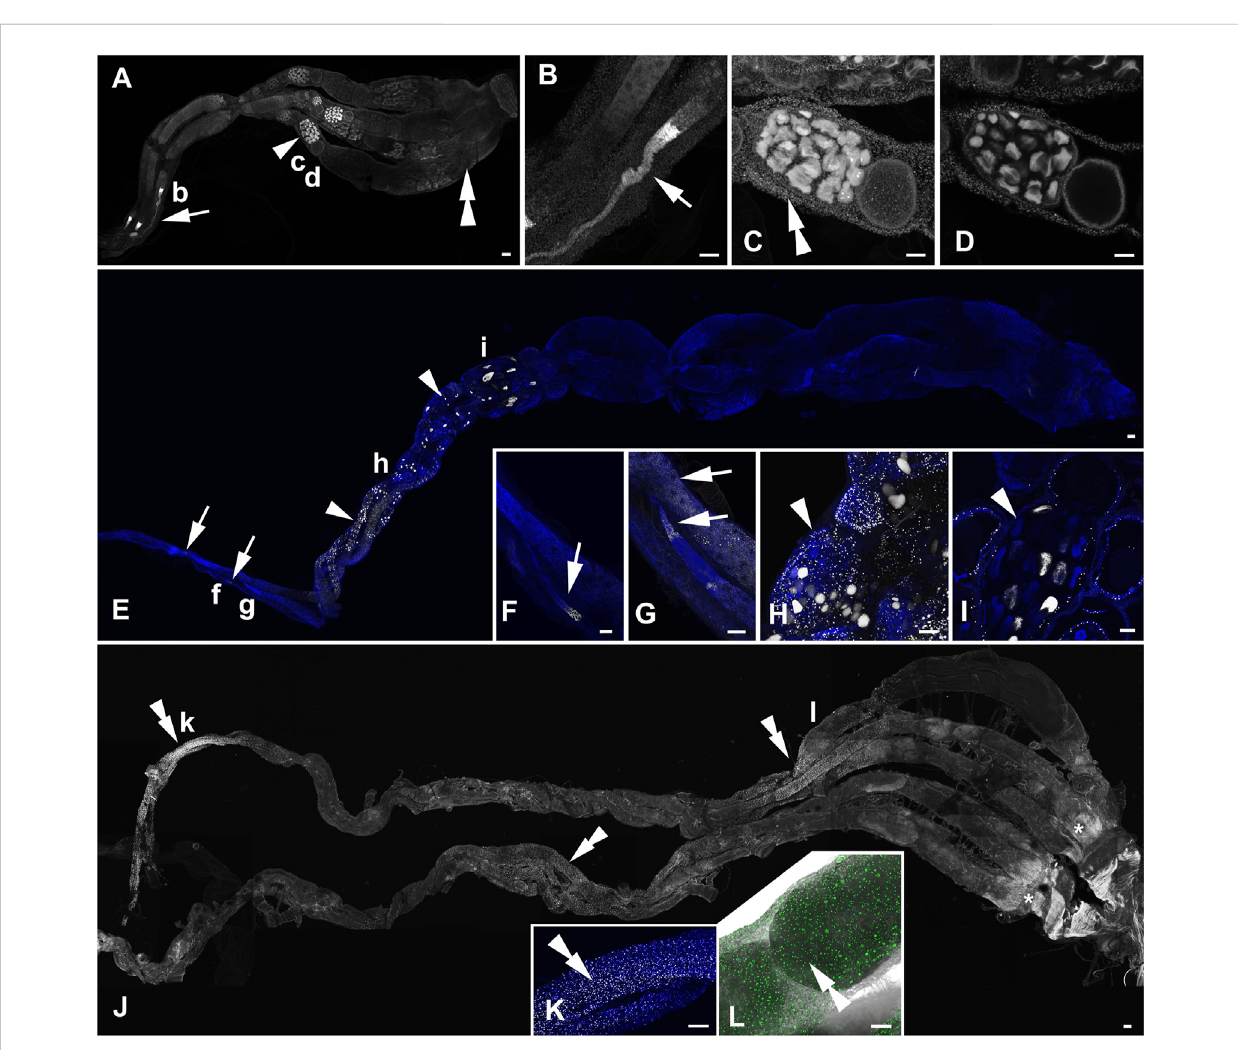
Active DNA synthesis in the ovaries of B. terrestris queens within a 12 h period. (A – D) The ovary of a representative of 3 to 8-day-old virgin queens. The3Dreconstructionofthewholeovary (A) ,strongEdU-labellingintheterminal fi lamentandtheanteriorpartofgermarium (B) ,theclose-upviewofan oocyte chamber with EdU-positive signals in nurse cells (trophocytes), follicle cells, and in the peritoneal sheath of the vitellarium in the Z stack reconstruction (C) ,andinasingleconfocallayer (D) . (E – I) Theovaryofarepresentativeof15-to20-day-oldmatedprediapausequeens.Mitotically active cells in the germarium and the vitellarium in the 3D reconstruction of the whole ovary (E) , details of the EdU-signal in the anterior part of the germarium (F,G) , the close-up view of EdU signals in follicle cells and some trophocytes in an egg chamber of the middle part of the vitellarium in the Z stack reconstruction (H) and in a single confocal layer (I) . (J – L) The ovary of a representative of 1-year-old queens. EdU labelling of some cells of the peritoneal sheath in the 3D reconstruction (J) , details of the proximal part of ovarioles (K) and the middle part of an ovariole (L, the fl uorescence signal is combinedwiththetransmittedlightimage).Thewhite (A – K) andgreencolors (L) indicatelocalizationofEdUincorporatedduringactiveDNAsynthesisin the nuclei, and the blue color (E – I,K) shows DNA labelled by DAPI. The arrows indicate the EdU signal in germ cells of the germarium. Arrowheads show EdU signals in nurse and follicle cells of the vitellarium. Double arrows indicate positive signals in cells of the peritoneal sheath. Asterisks indicate non- speci fi c fl uorescence signals (J) . Small letters in the ovary overviews indicate the locations from which the corresponding high-magni fi cation images were taken. The scale bars in (A,E,J) 100 µm and in (B-D,F – I,K,L) 50